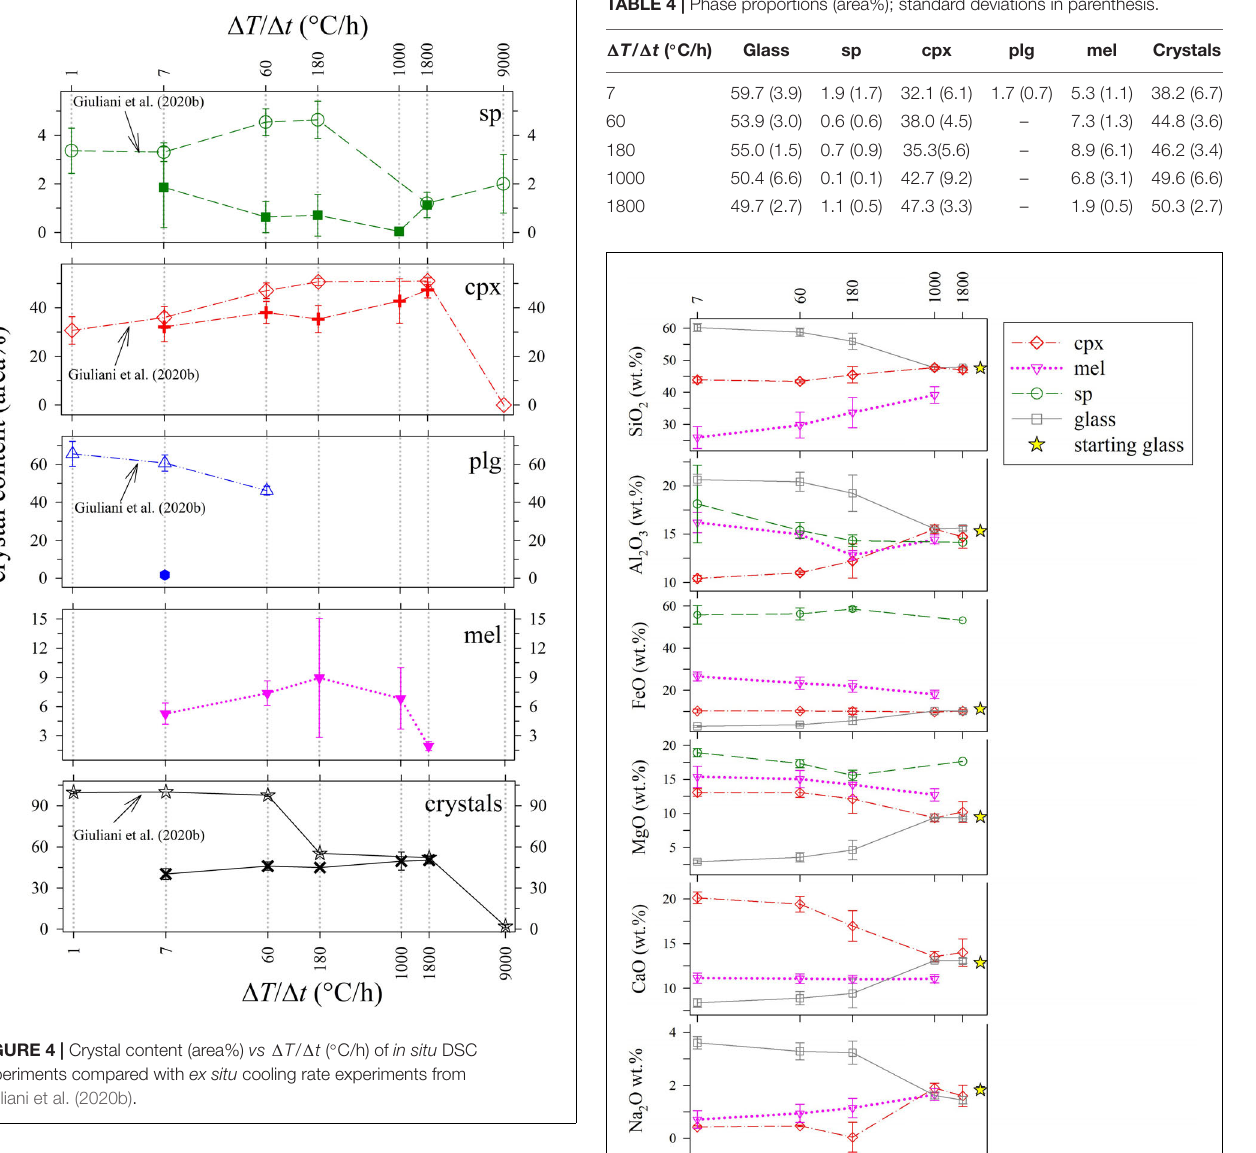
TABLE 4 | Phase proportions (area%); standard deviations in parenthesis.